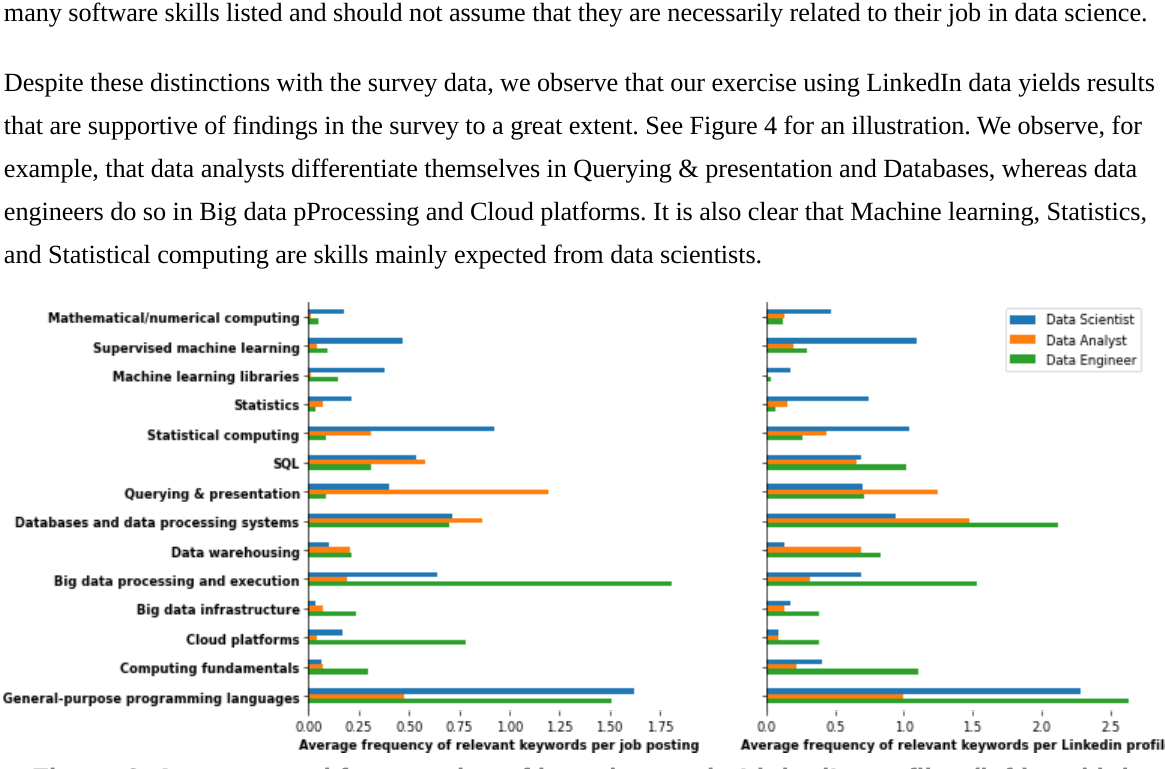
Figure 6. Average total frequencies of key phrases in LinkedIn profiles (left) and job postings (right), as identified as relevant to selected subjects in the IADSS knowledge framework. Note that the results mostly align with the questionnaire responses (see, for instance, pairwise comparisons in Tables